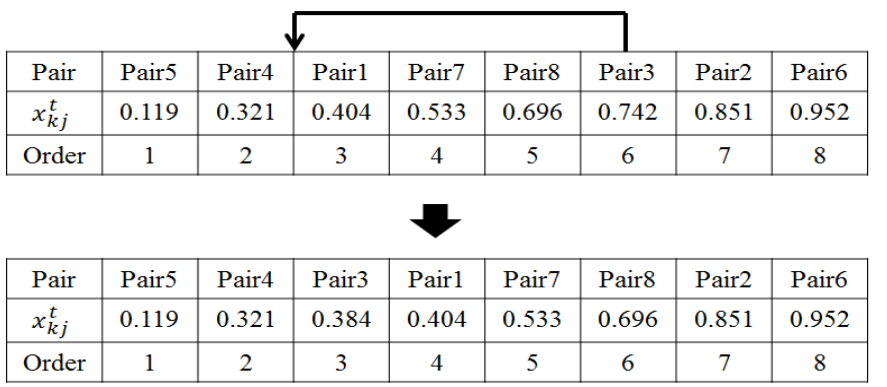
Figure 3. Insertion.